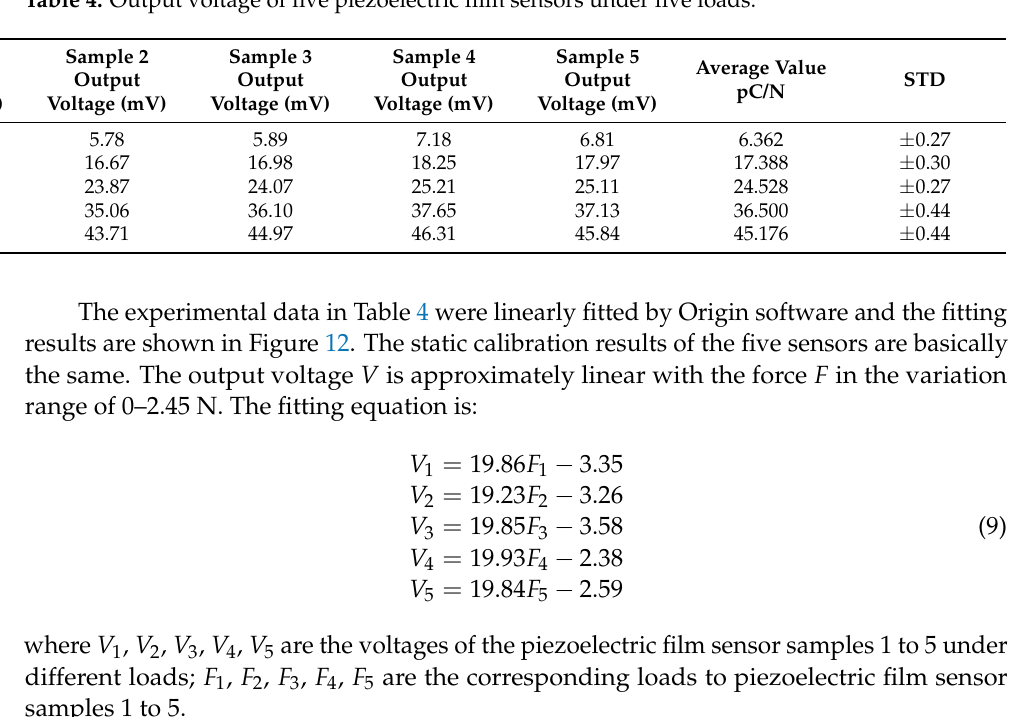
Table 4. Output voltage of five piezoelectric film sensors under five